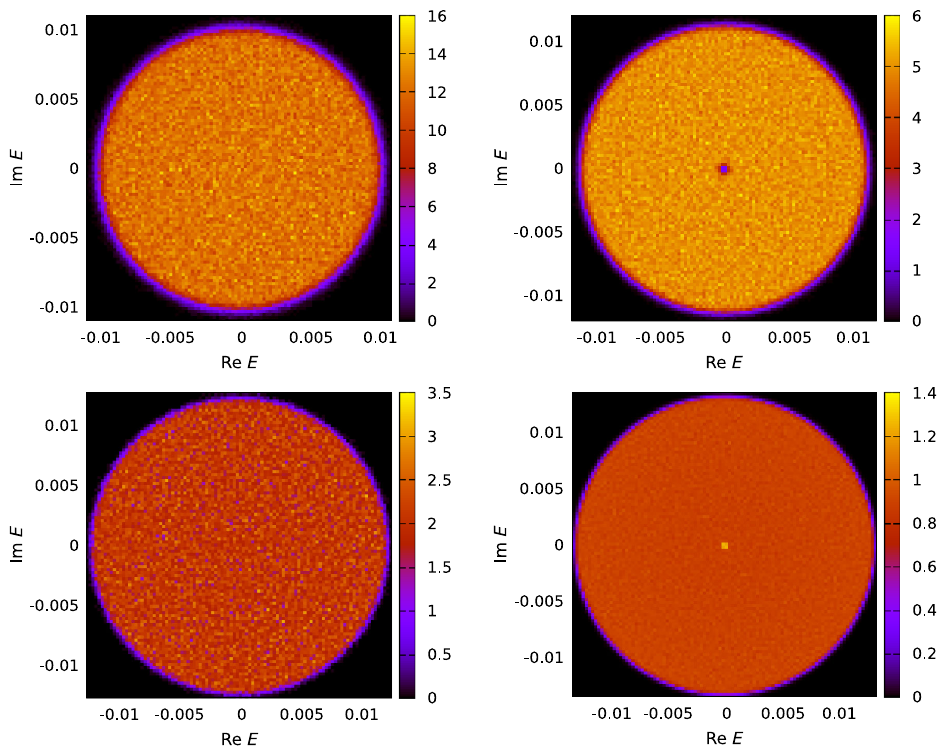
FIG. 4. Spectral density of the complex eigenvalues of the nHSYK Hamiltonian of Eq. (1) for q ¼ 6 and N ¼ 18 (top-left panel), 20 (top-right panel), 22 (bottom-left panel), and 24 (bottom-right panel). As in the previous cases, the average spectral density is radially symmetric. However, we observe distinctive features as well. The spectrum has inversion symmetry for N ¼ 20 , 24, but, unlike for q ¼ 3 and to a lesser extent for q ¼ 4 , the density is rather unstructured except in the j E j → 0 region where, depending on N , we observe either a sharp suppression ( N ¼ 20 ) or a strong enhancement ( N ¼ 24 ). Also in this case, we find a sharp